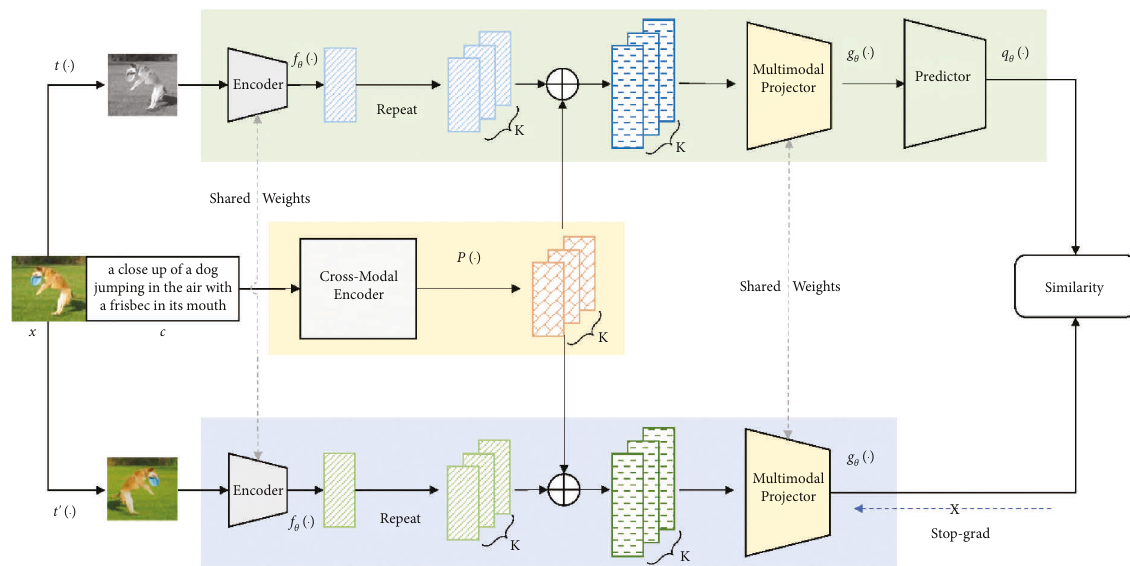
Figure 3: The architecture of